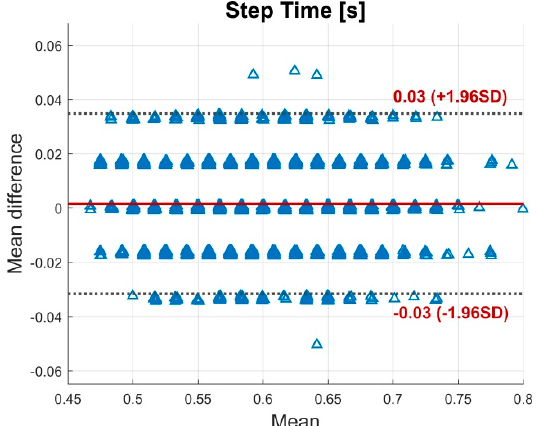
Figure A7. BA plot for the step time. The plot contains all calculated data points of all subjects. The solid line indicates the mean difference. The dashed lines indicate the LoA (95% CI of the mean difference).